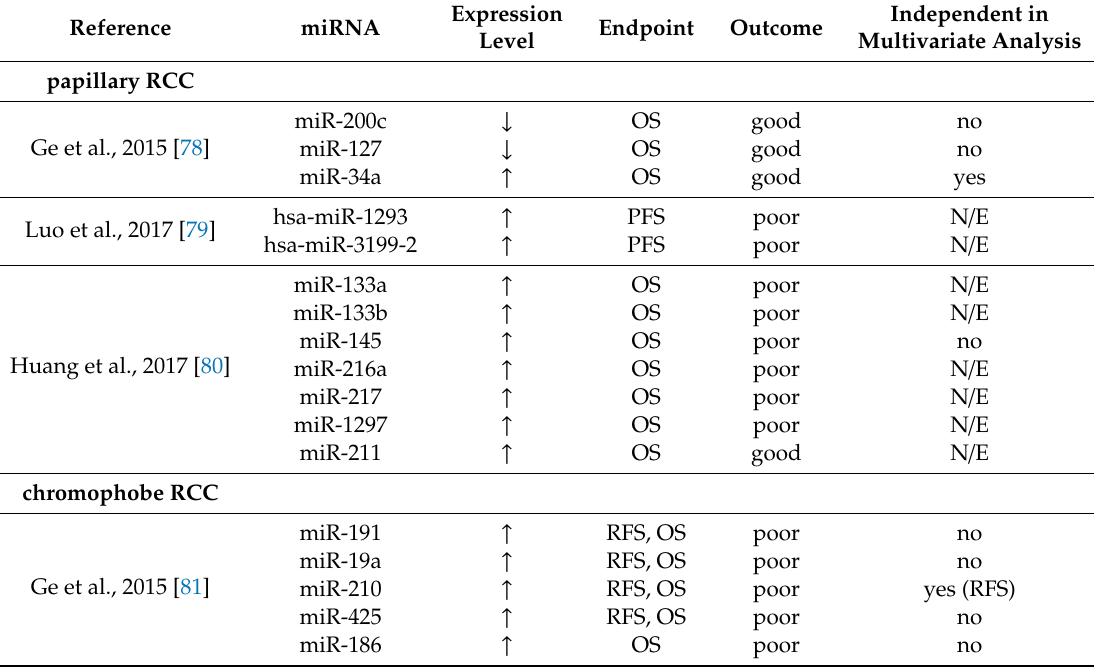
Table 1. miRNAs significantly associated with outcomes in